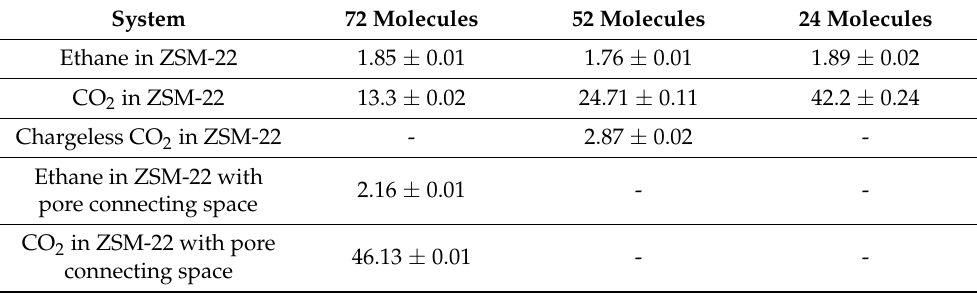
Figure 6. Reorientational correlation function R(t) for CO 2 and ethane in ZSM-22 at a loading of 52 molecules in the simulation cell. In the legend, nCO 2 indicates results from the simulation of CO 2 without electrostatic interactions. Table 4. Time constants τ (in ps) of the decay of the rotational correlation functions above 1